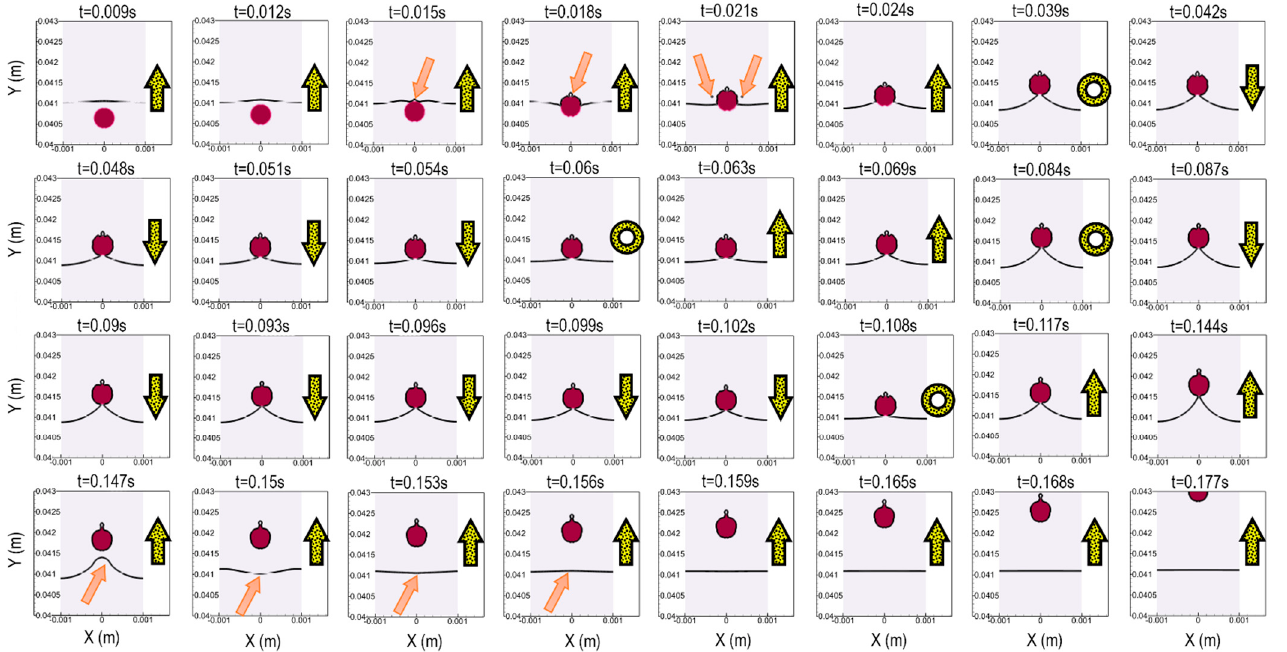
Figure 4. The behavior of a droplet when it crosses the border of a fluidic barrier; the solid black line shows the fluidic barrier edge. Yellow arrows refer to the direction of motion of the droplet, yellow circles show the instance at which the droplet stops and its moving direction reverses, and the orange arrows refer to important details that should be noticed.